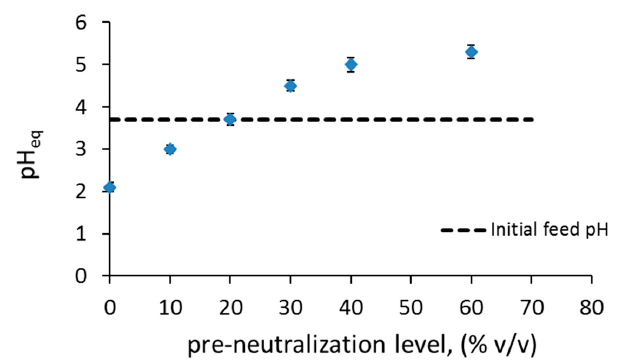
Figure 3. Effect of pre-neutralization level on equilibrium pH after separation of Co and Ni, using 20%